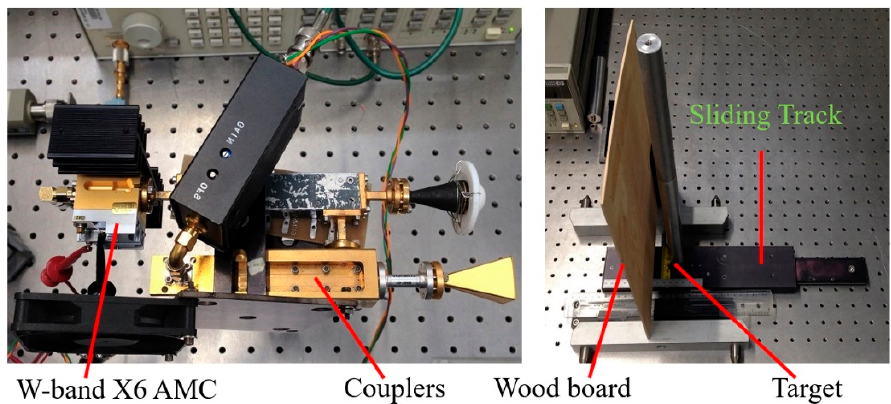
Figure 3. Photographs of the prototype W-band swept-FM radar system and the translatable target region.